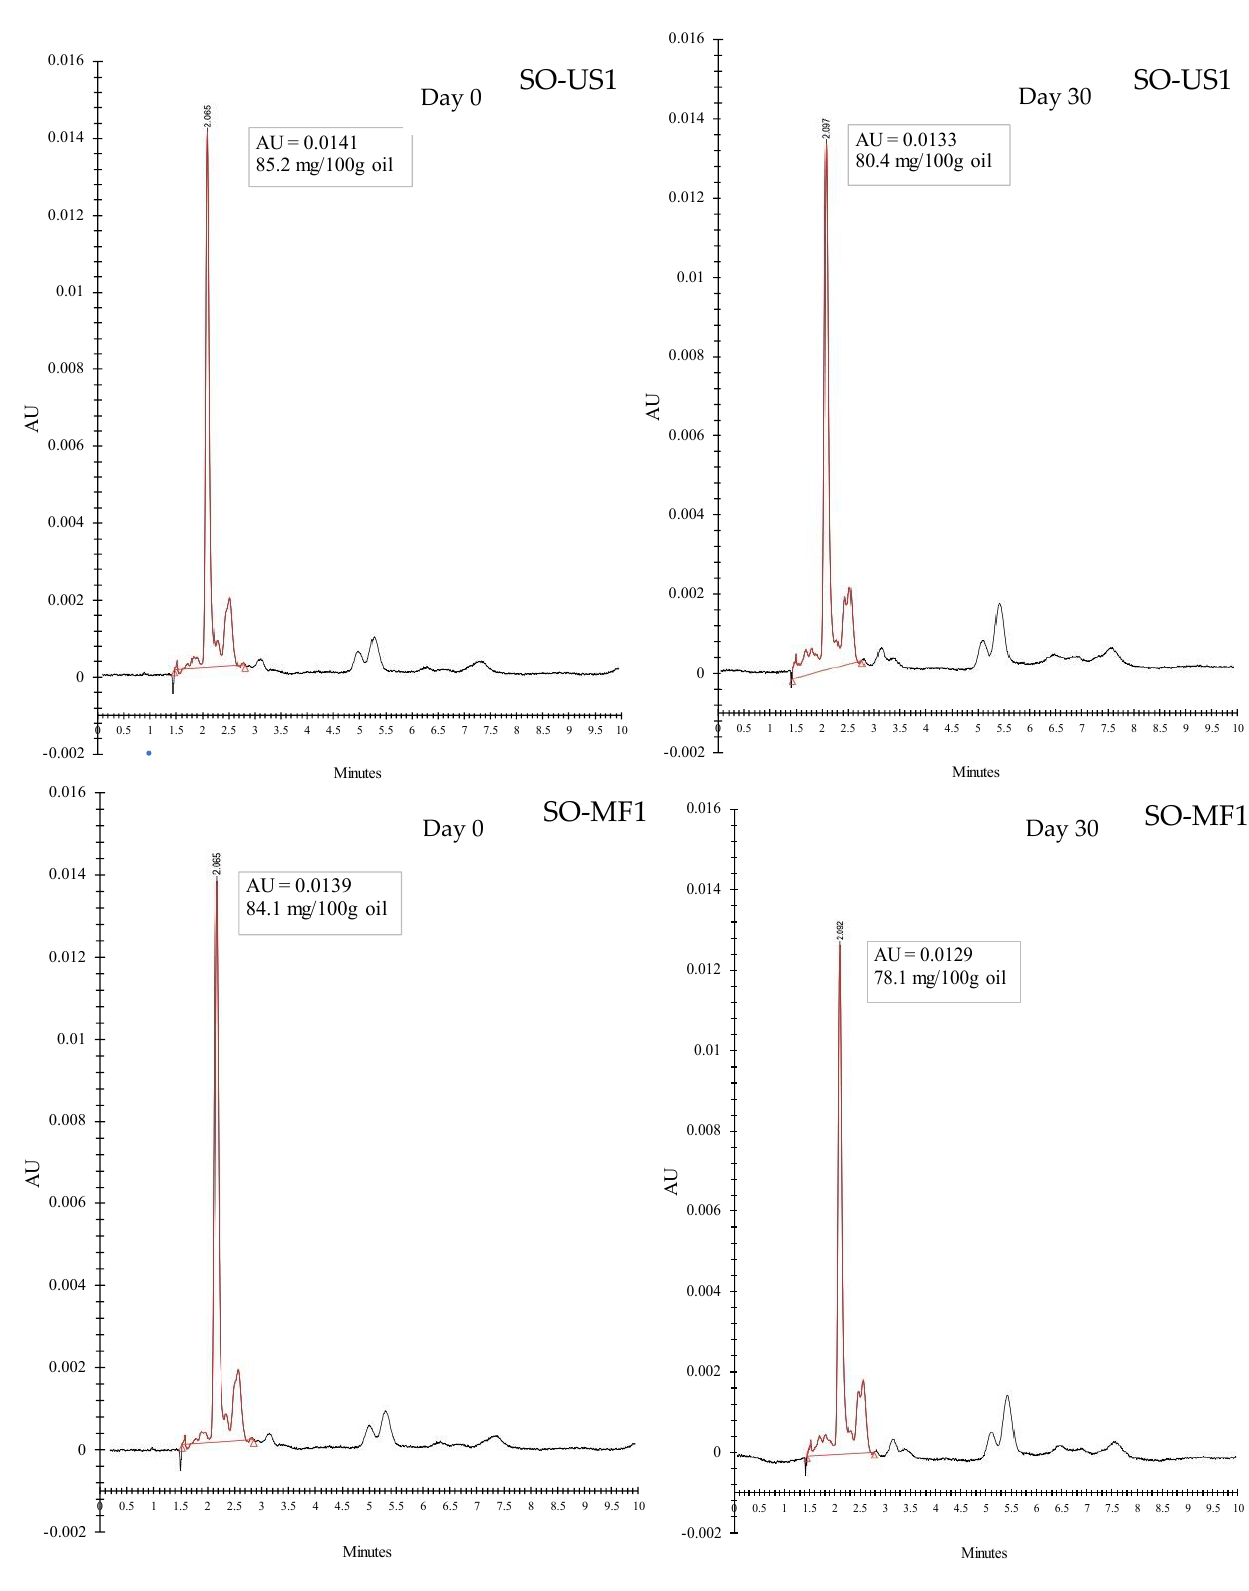
Figure 4. HPLC chromatograms of SO, SO-US1 and SO-MF1 at day 0 and day 30 of storage at room temperature (28-30 °C). SO, shrimp oil; SO-US1, shrimp oil extracted from ultrasonicated KBPI-KC-SO microcapsules containing 0.1% SO; SO-MF1, shrimp oil extracted from microfluidized KBPI-KC-SO microcapsules containing 0.1% SO. Astaxanthin content was calculated from peak